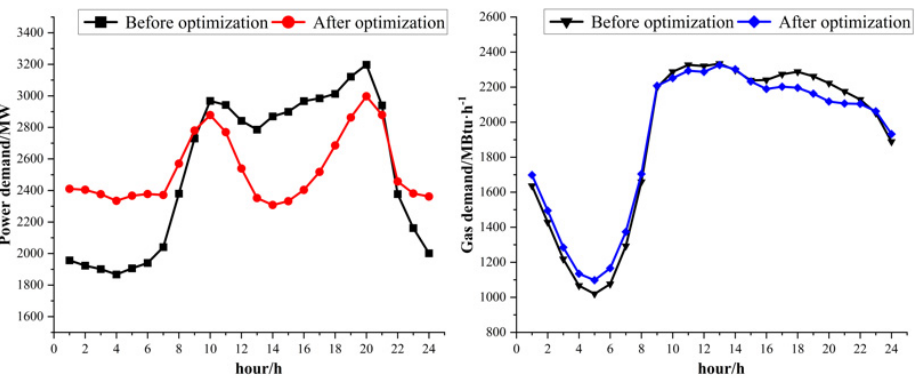
Figure 10. The total power/gas demand before and after the optimization in Scenario 2.